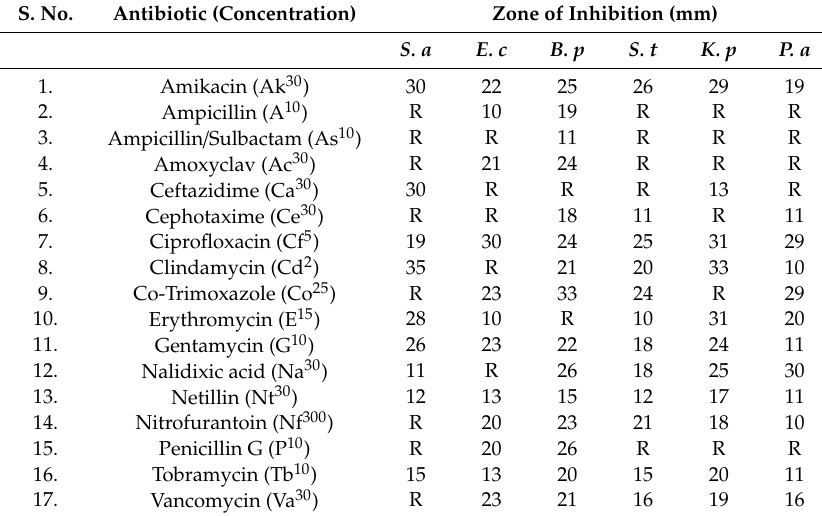
Table 1. Resistance profile of bacterial strains against di ff erent antibiotics. S.